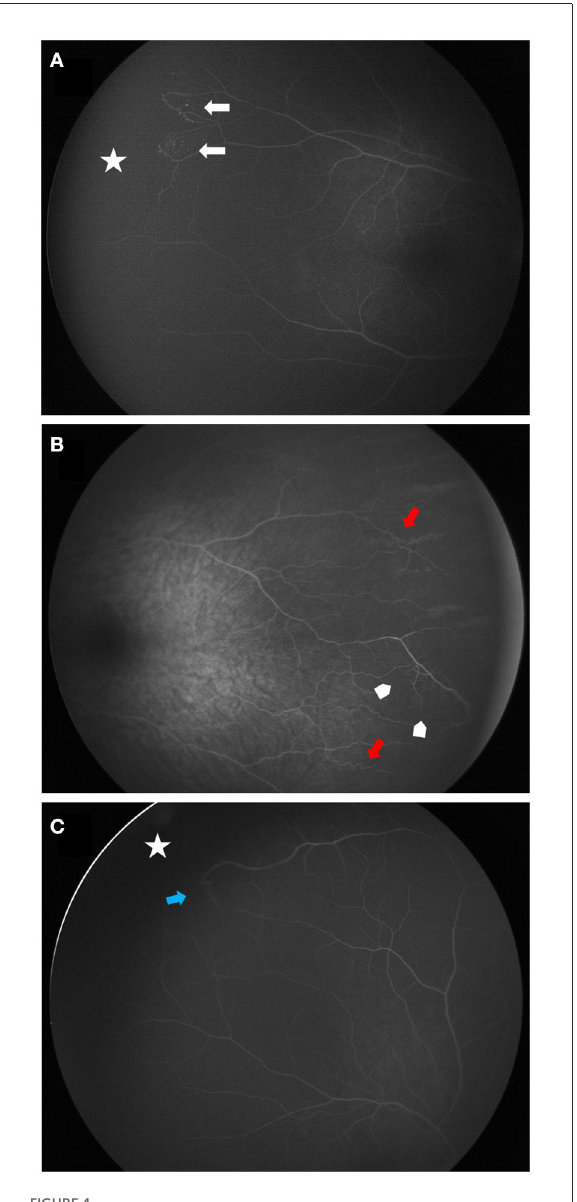
FIGURE4 Wide angle fluorescein angiographies of contralateral vascular abnormalities in patients with Coats disease. (A) shows a peripheral avascular retina (white star) lined with telangiectasia (white arrows) (stage 1). (B,C) are classified stage 0. (B) demonstrates peripheral vascular tortuosity (red arrows) associated with dilatation of the capillary meshwork (arrow heads). (C) shows a peripheral avascular retina (white star) lined with a vascular anastomosis (blue